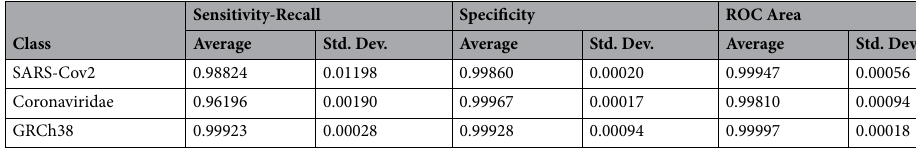
Table 5. Results of sensitivity, specificity, and ROC area for MLP classifier in the SARS-CoV-2 test scenario (results from dataset with 50% overlap).